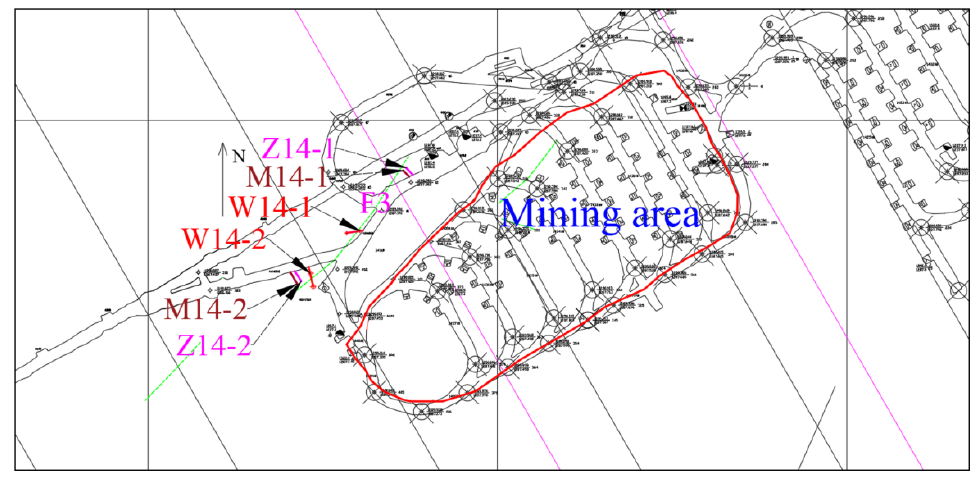
Figure 8. Schematic diagram of the arrangement of measuring points in each sublevel. ( a ) Measuring point position diagram of sublevel 10. ( b ) Measuring point position diagram of sublevel 11. ( c ) Measuring point position diagram of sublevel 12. ( d ) Measuring point position diagram of sublevel 13. ( e ) Measuring point position diagram of sublevel 14.